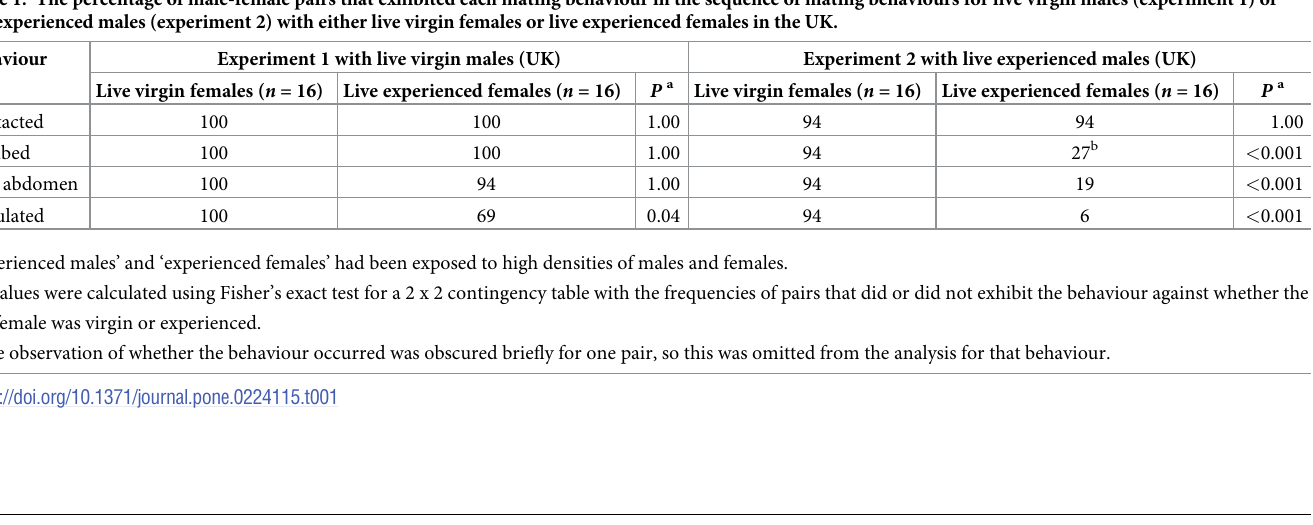
Table 1. The percentage of male-female pairs that exhibited each mating behaviour in the sequence of mating behaviours for live virgin males (experiment 1) or live experienced males (experiment 2) with either live virgin females or live experienced females in the UK. Behaviour Experiment 1 with live virgin males (UK) Experiment 2 with live experienced males (UK) Live virgin females ( n = 16) Live experienced females ( n = 16) P a Live virgin females ( n = 16) Live experienced females ( n = 16) P a